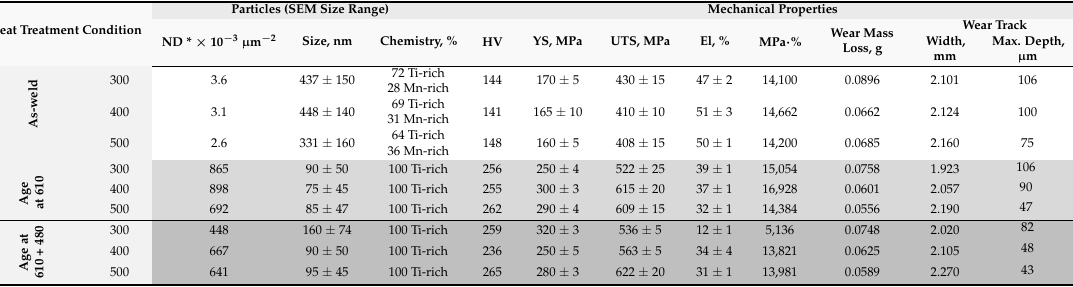
Table 2. The microstructural parameters and mechanical properties variation with heat treatment in Monel K500.